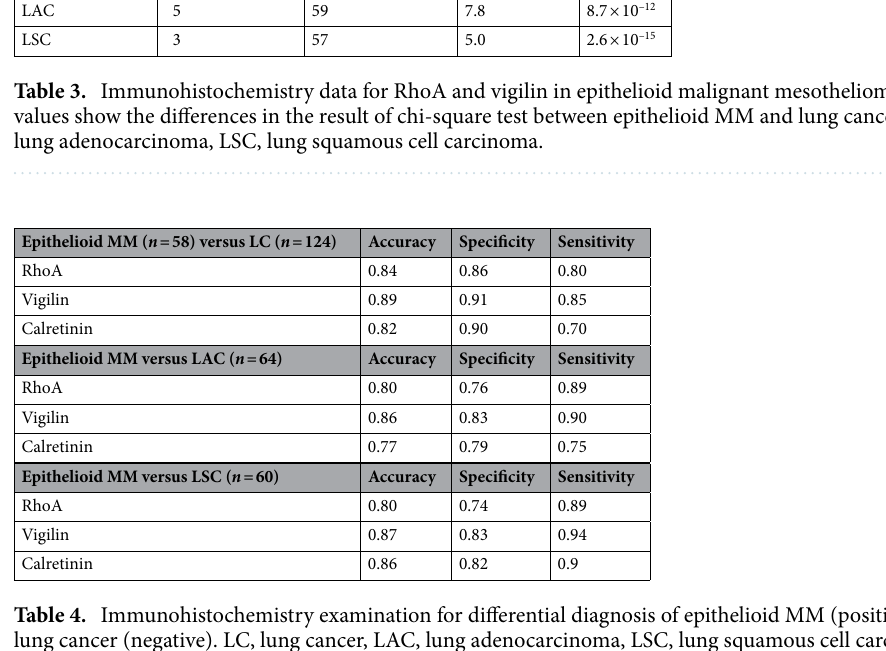
Table 4. Immunohistochemistry examination for differential diagnosis of epithelioid MM (positive) from lung cancer (negative). LC, lung cancer, LAC, lung adenocarcinoma, LSC, lung squamous cell carcinoma.